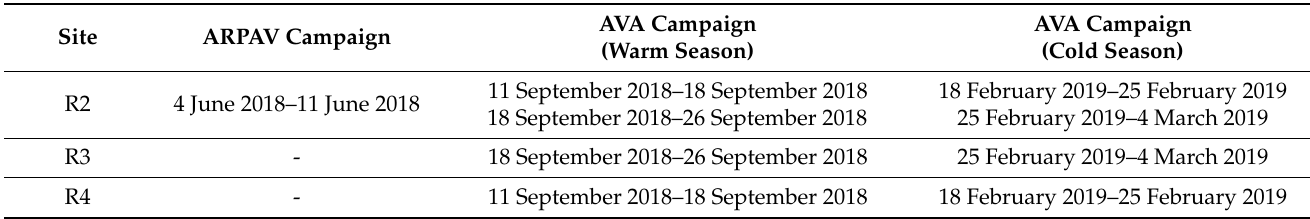
Table 3. Schedule of the short-period campaigns at the monitoring sites R2, R3, and R4.